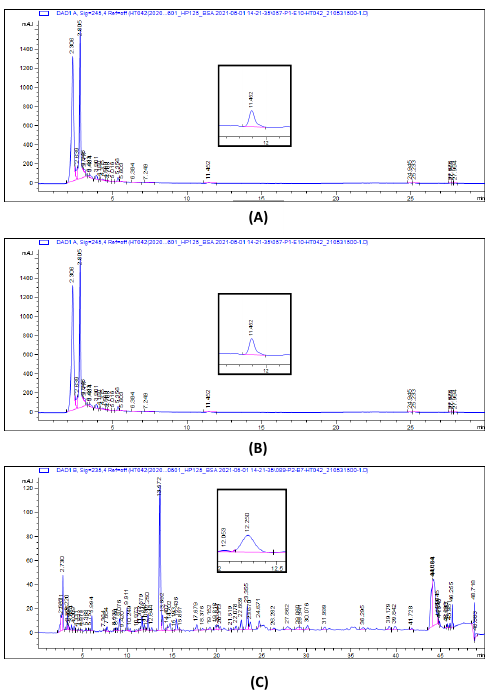
Figure 1. High performance liquid chromatography chromatograms of formononetin (A), eleuthe- roside E (B) and shanzhiside methyl ester (C) in HT042.